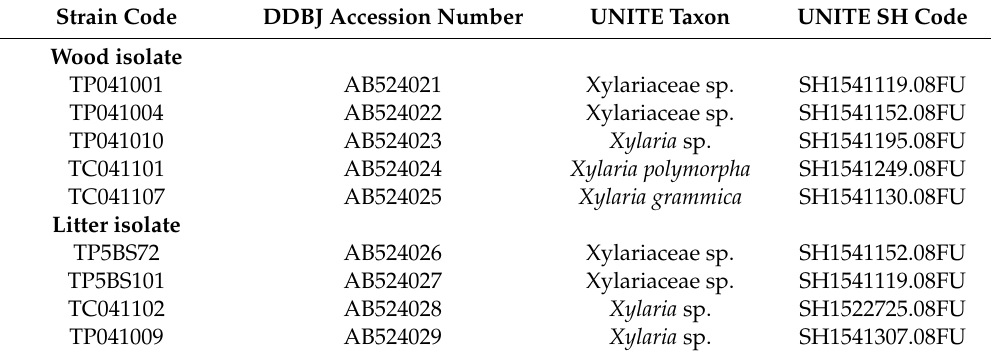
Table 1. Xylaria isolates used in the test. UNITE species hypothesis (SH) at 1.5% threshold is indicated